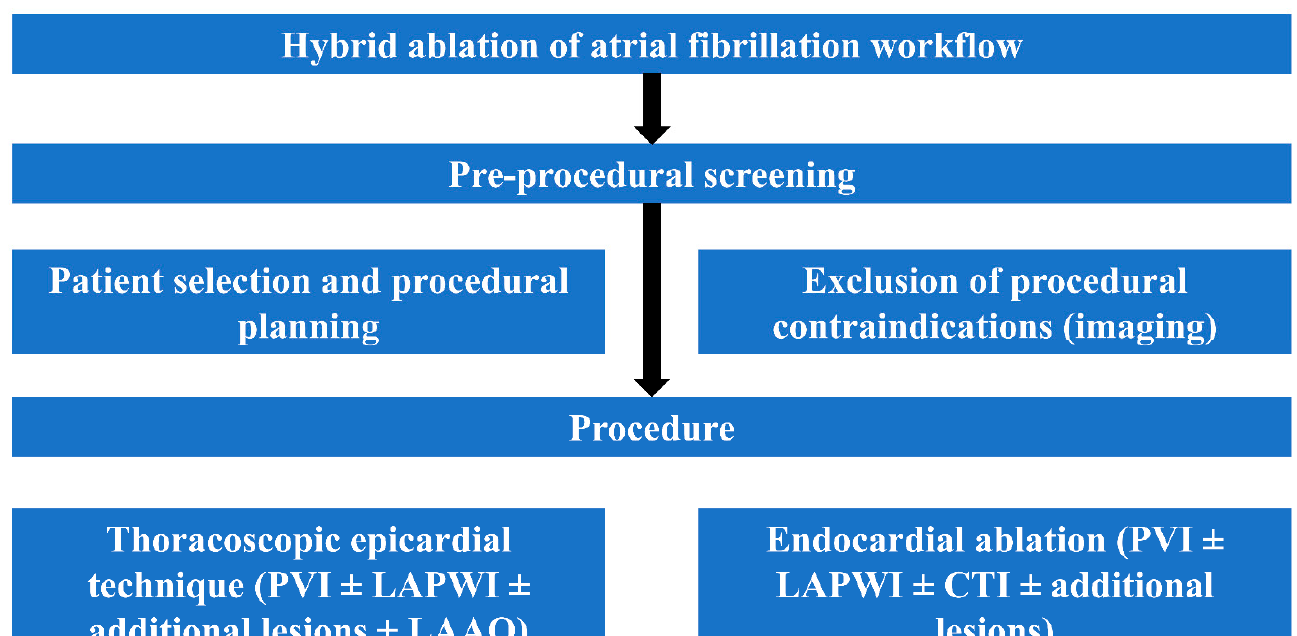
Figure 3. Hybrid AF ablation workflow overview.